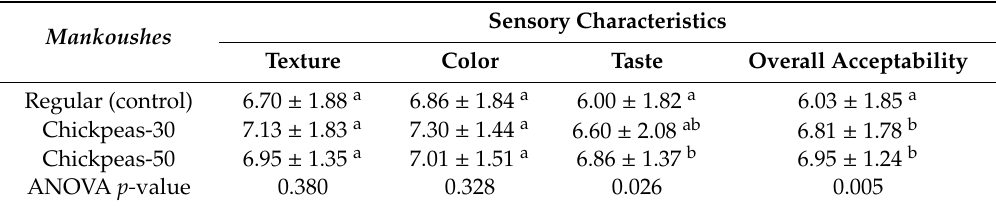
Table 5. Sensory acceptability rating of regular, chickpea-30, and chickpea-50 mankoushes